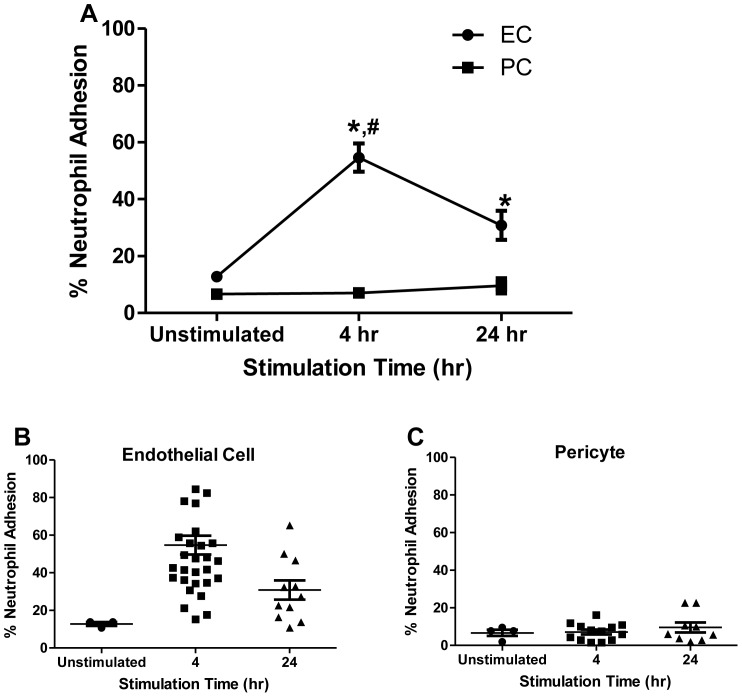
Neutrophil adhesion to IL-1β-activated EC or PC monolayers.Freshly isolated (naïve) neutrophils were seeded onto EC or PC monolayers previously activated with IL-1β for 4 or 24 hr in Sykes-Moore chambers and allowed to adhere prior to counting. Data are represented (A) as a line plot of neutrophil adhesion to EC or PC or as a scatterplot of neutrophil adhesion to (B) EC or (C) PC. Line data represents average neutrophil adhesion ± SEM. *P<0.05, when compared with PC at same timepoints; #P<0.05 when compared with unstimulated EC.